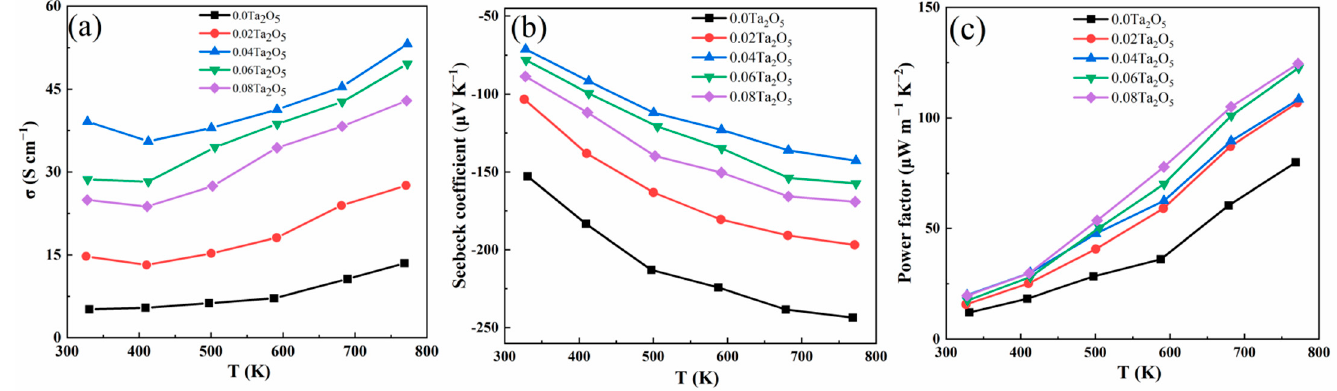
Figure 4. Temperature dependences of ( a ) electrical conductivity, ( b ) Seebeck coefficient, and ( c ) power factor of Bi 2 − x Ta x O 2 Se (x = 0, 0.02, 0.04, 0.06, and 0.08) ceramics. Table 2. Carrier densities, Hall mobilities, effective masses m* , and densities ρ of Bi 2 − x Ta x O 2 Se (x = 0, 0.02, 0.04, 0.06, and 0.08) ceramics at room temperature. Samples